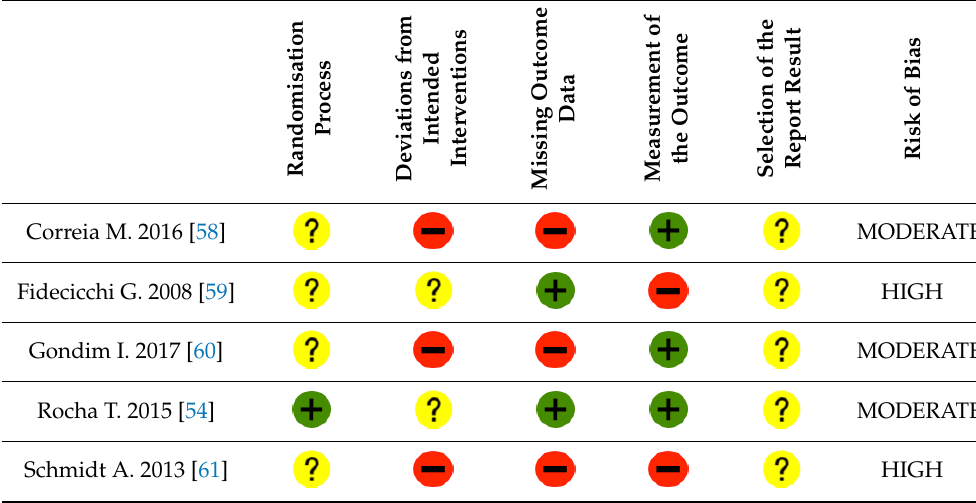
Table 5. GRADE evaluation of the studies on pump techniques: quality of evidence and strength of recommendations. Quality Summary of Findings Outcome (No. of